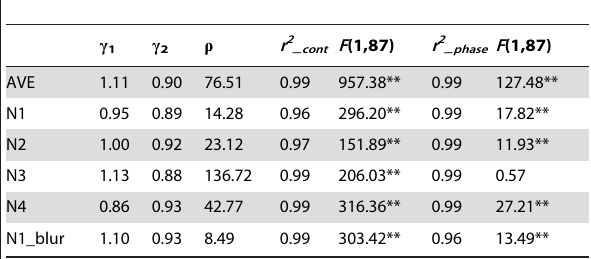
Table 1. Parameters of the best fitting